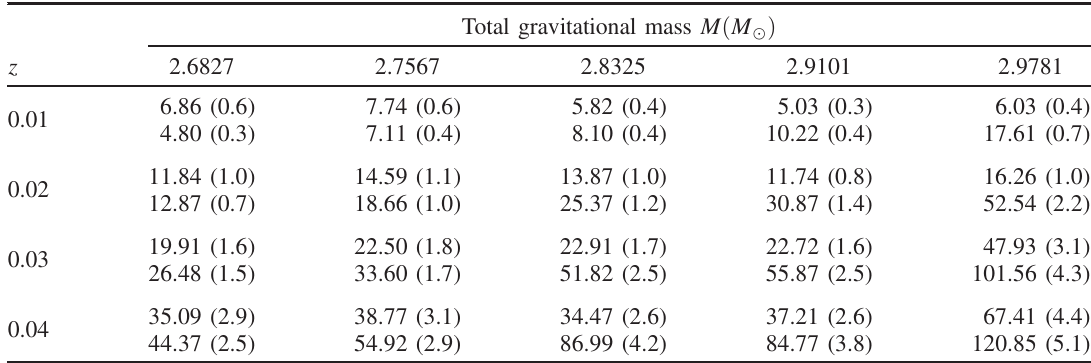
TABLE III. The absolute measurement uncertainties in the redshifted characteristic frequencies of the dominant HMNS spectral features. The corresponding percentage uncertainties are given in brackets. We show pairs of results in units of Hz for f 1 (upper rows) and f 2 (lower rows) for each redshift and for each of the five total gravitational masses. Each value represents half of the span of the 68% confidence region on the frequency measurement averaged over 100 different noise realizations, source, and sky